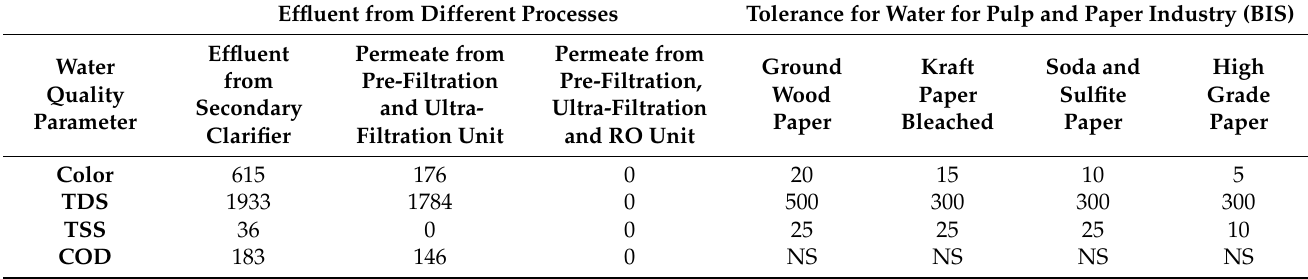
Table 4. Water Quality requirements for paper and pulp industries in